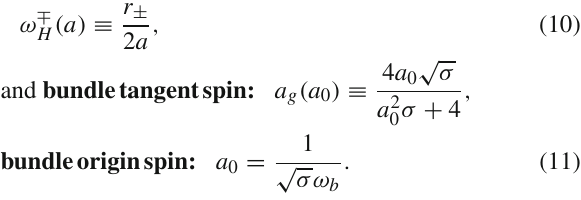
the extended plane as function of r / M and σ = sin θ 2 . Center panel: the bundle origin spin a 0 ( r g ) of Eq. (26) as function of the tangent spin r g ∈ [ 0 , 2 M ] in the plane (σ, r / M ) . Right panel: the origin frequen- cies (singularity frequencies) ω ± = constant for r = 0 in the plane (σ, r / M ) see Eq.